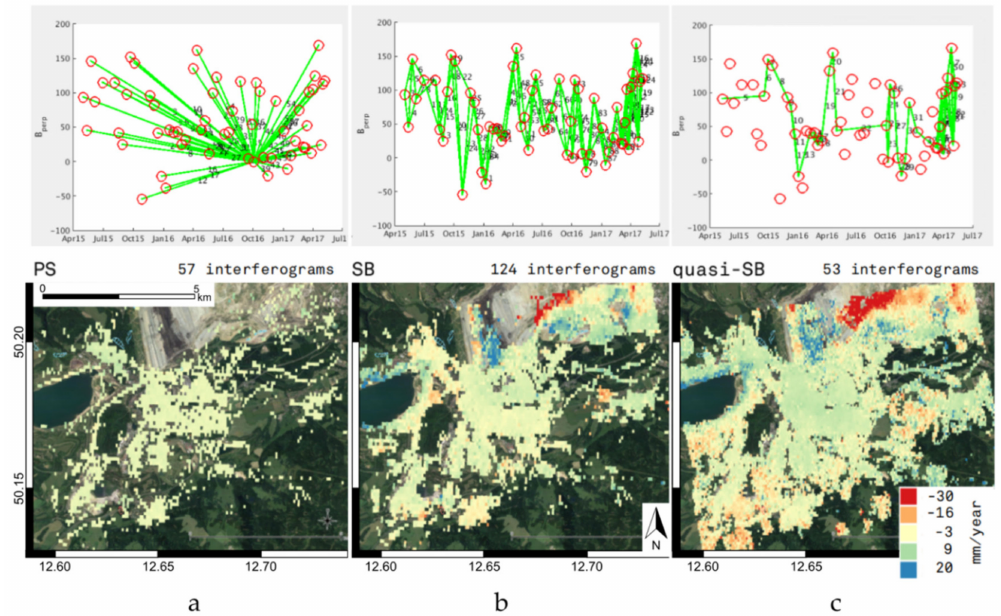
Figure 4. Sokolov open pit mine area processed by IT4S1 approaches (burst ID 44_2_8161): ( a ) STAMPS Persistent Scatterers (PS), ( b ) standard STAMPS Small Baseline (SB) and ( c ) optimised STAMPS quasi-SB using coherence threshold of 0.4. Top subfigures show plot of applied interferometric combinations, the bottom subfigures show estimated mean line-of-sight (LOS) displacement